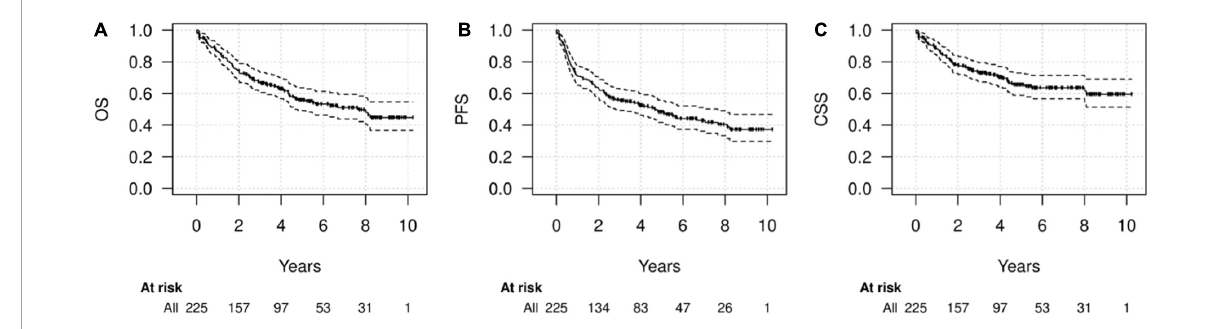
FIGURE2 Survival of the whole cohort. Kaplan-Meier diagrams for overall survival (OS) (A) , progression-free survival (PFS) (B) , and cancer-specific survival (CSS) (C) in the whole